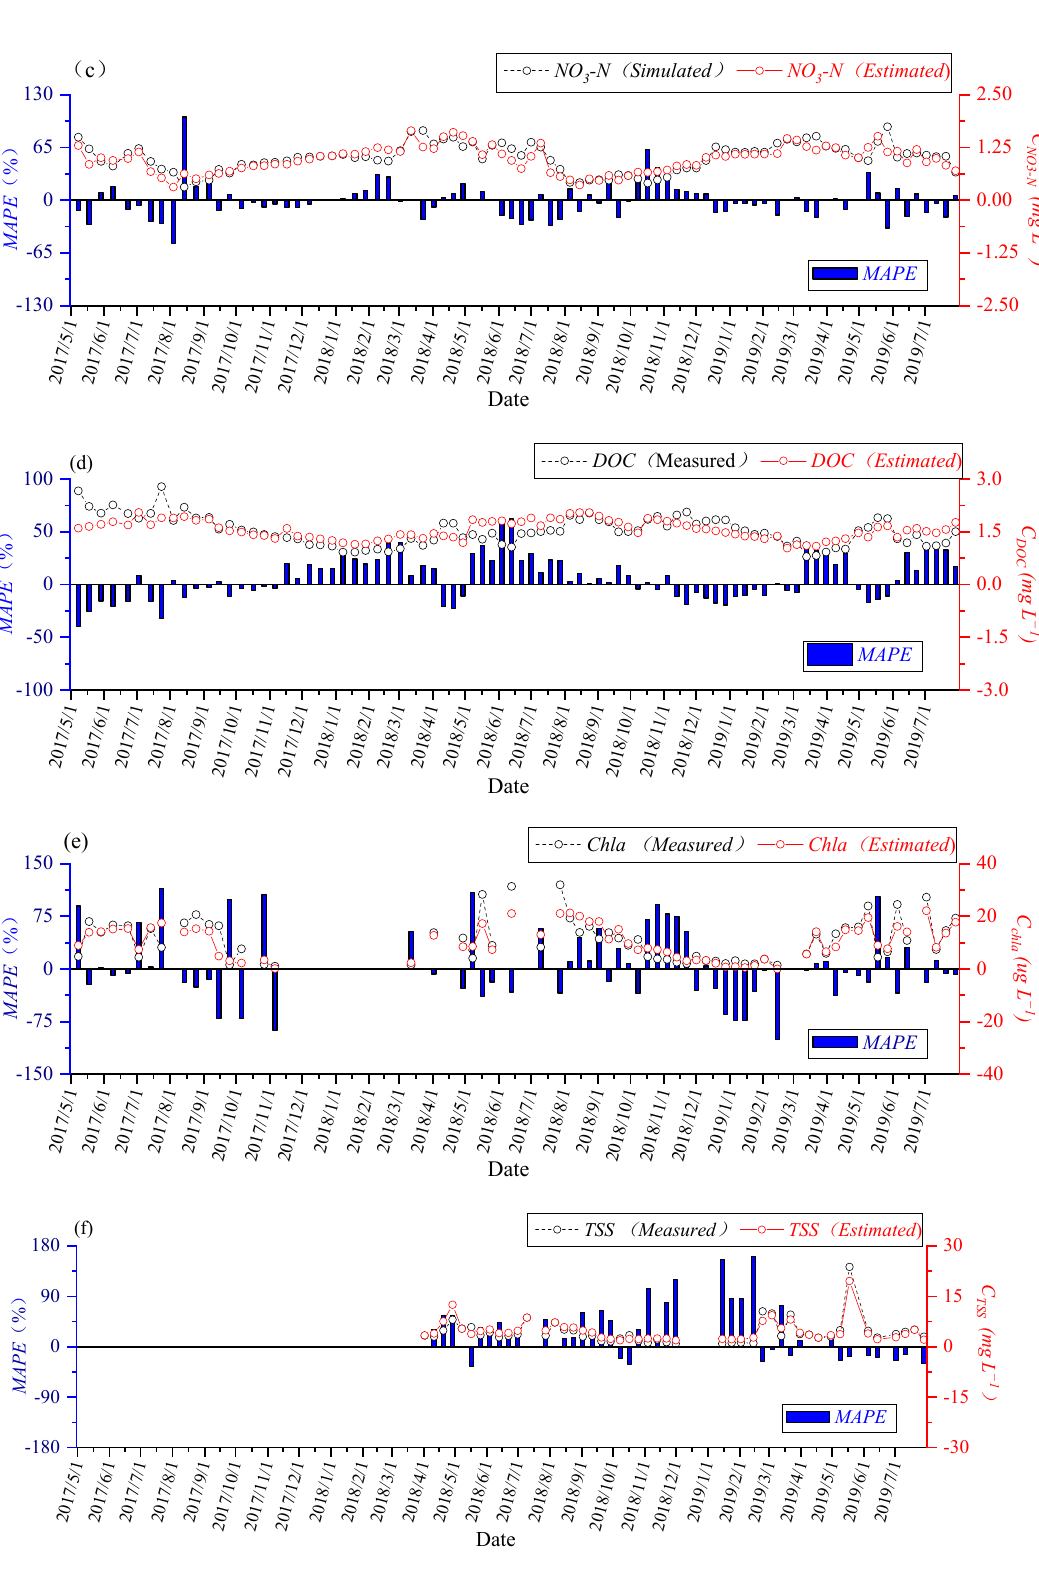
Figure 4. Temporal variations of estimated concentration, measured concentration and MAPE. ( a ) TN; ( b ) TP; ( c ) NO 3 -N; ( d ) DOC; ( e ) Chl a ; ( f ) TSS.